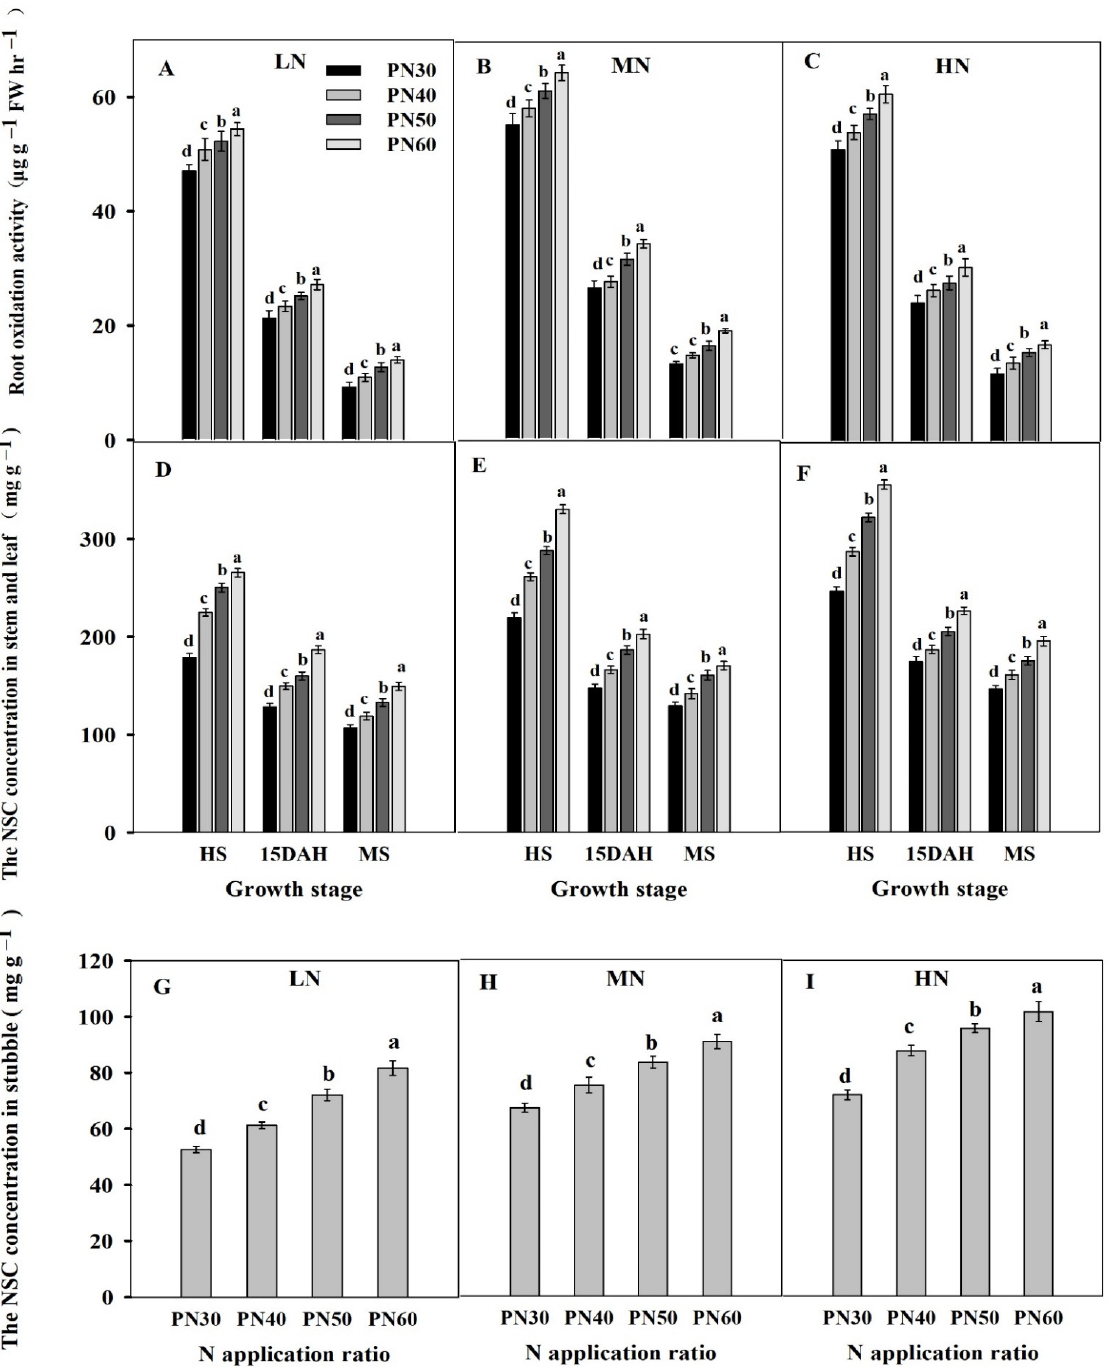
Figure 5. Effects of N rate and the ratio of the main crop on root oxidation activity ( A – C ), NSC concentration in the stem and leaf ( D – F ) after heading of the main crop and in the stubble ( G – I ). Error bars are ± SE. Note: LN, low N rate (the total amount of N applied was 100 kg ha − 1 ); MN, medium N rate (the total amount of N applied was 250 kg ha − 1 ); HN, high N rate (the total amount of N applied was 400 kg ha − 1 ). PN30, PN40, PN50, and PN60 correspond to N application ratios of basal tillering fertilizer to panicle fertilizer of 7:3, 6:4, 5:5, and 4:6, respectively. HS, full heading stage of the main crop. DAH, days after heading of the main crop. MS, maturity stage of the main crop. The different lowercase letters at the same growth stage indicate significant differences at the 5% probability level according to the LSD